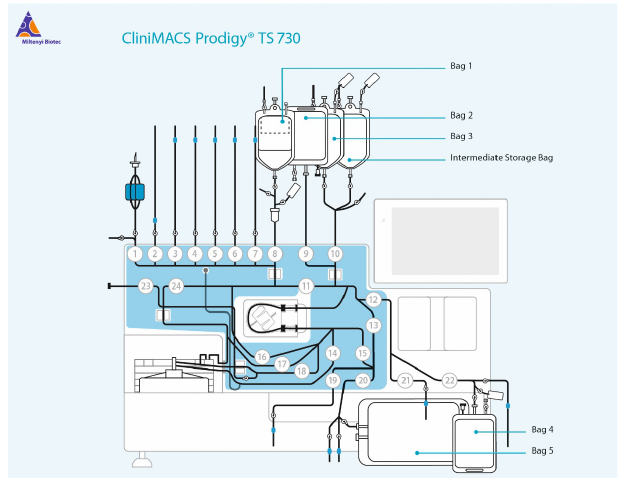
Figure A1. Schematic overview of the CliniMACS Prodigy ® with tubing set TS730. Additional bags can be attached by sterile welding to the tubes at valves 1–7 and contained liquids (buffer, media, cells, etc.) are transferred through the device by a peristaltic pump (central position) directed by opening/closing of valves (1–24). Here, several predefined modules allow the user to operate the device through the touchscreen (top right). In the Centricult unit (bottom left), cells can be cultured, centrifuged or a microscopic picture can be taken at conditions chosen by the user. Supernatants are discarded in the waste bag (Bag 5) or to additional sample bags attached by sterile welding. Copy- right © 2023 Miltenyi Biotec B.V. & Co. KG. All rights reserved.